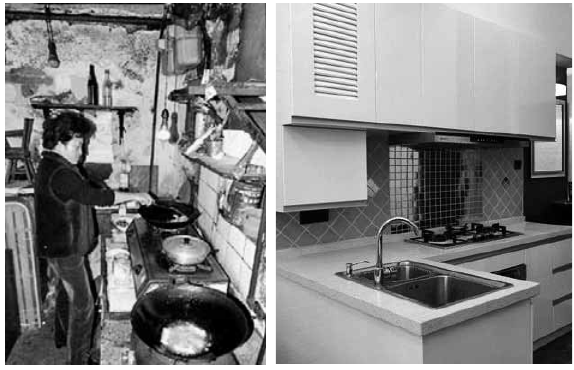
fig. 5. The shared old kitchen (left); The individual upgraded kitchen (right) Source: Photo by the first